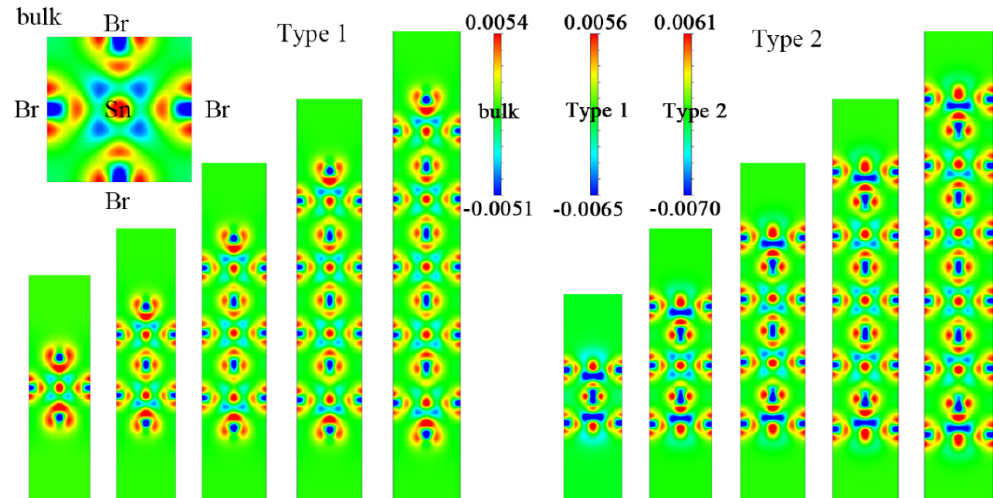
Figure 2. Electron density difference in the slice plane (0.5, 0, 0) in Cs n +1 Sn n Br 3 n +1 and Cs n Sn n +1 Br 3 n +2 ( n = 1–5). The top left corner is the electron density difference of the bulk CsSnBr 3 . The scale is in electrons/Å.